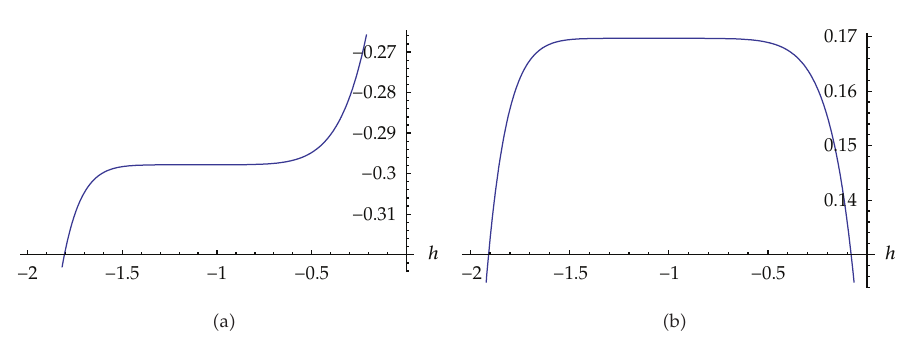
Figure 5: (cid:2) a (cid:3) The h curve of system (cid:2) 1.3 (cid:3) for u (cid:2) 3 , 1 (cid:3) obtained from the 10th order HAM. (cid:2) b (cid:3) The h curve of system (cid:2) 1.3 (cid:3) for v (cid:2) 3 , 1 (cid:3) obtained from the 10th order HAM.